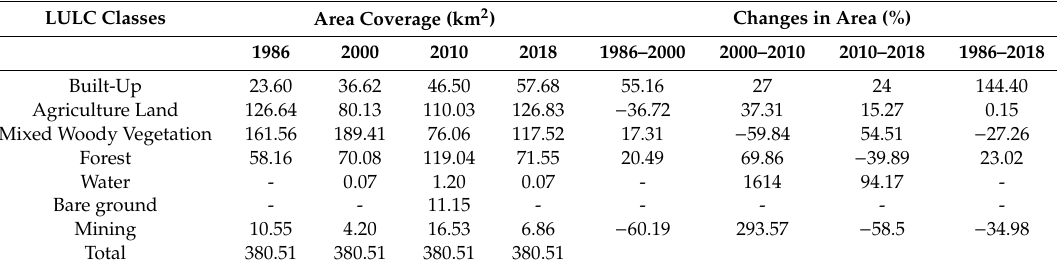
Figure 4. Maps showing LCC characteristics in Obuasi (1986–2018). Note: ‘mixed wood vegetation’ is presented in the legend as ‘mixed vegetation’. Table 2. Land cover characteristics in Obuasi